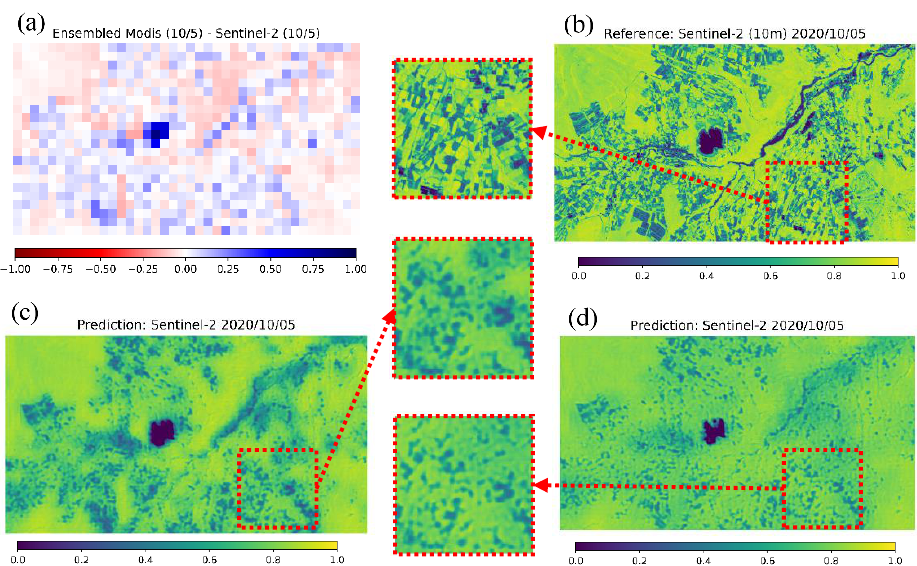
Figure 9. Qualitative result for MODIS prediction in Tsumagoi (5 October 2020). ( a ) Error between MODIS and Sentinel-2 NDVI before input. ( b ) Reference 10-m NDVI from Sentinel-2. ( c ) Prediction with up-sampled 250-m Sentinel-2 NDVI as input. ( d ) Prediction with 250-m MODIS NDVI as input.